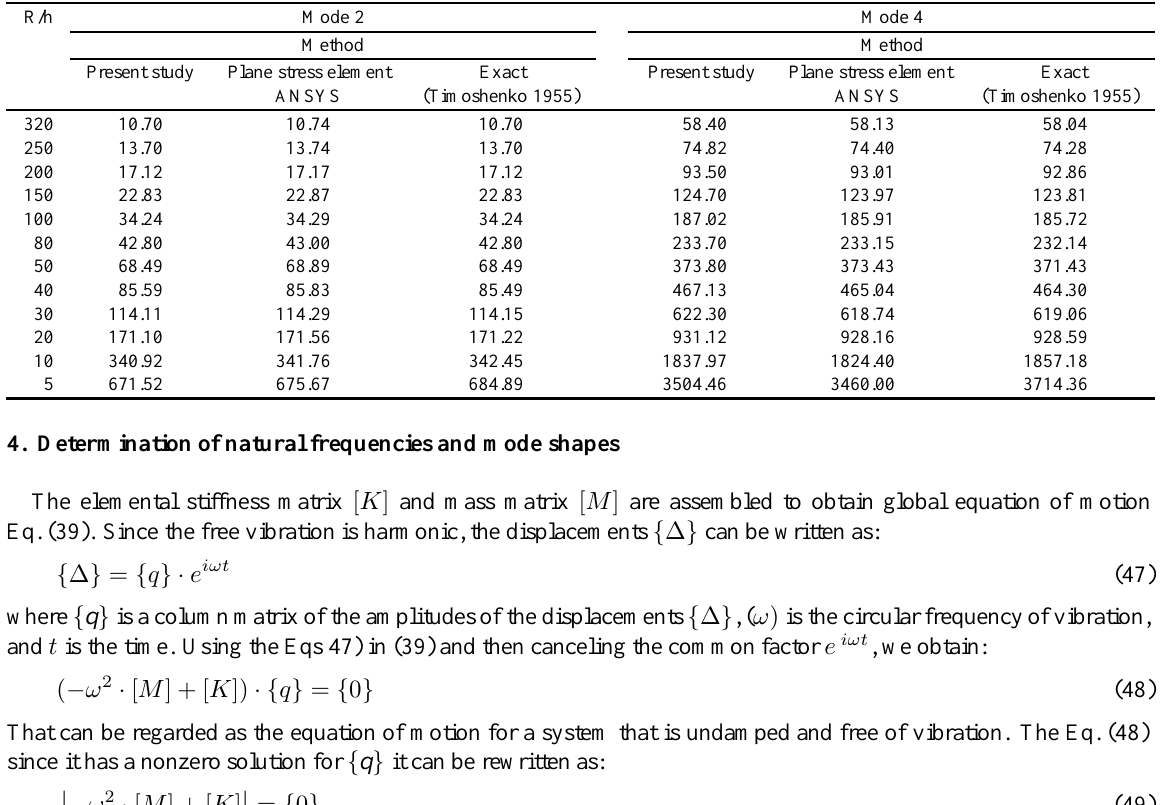
Table 1 Natural frequencies (HZ) for a circular ring computed by two present